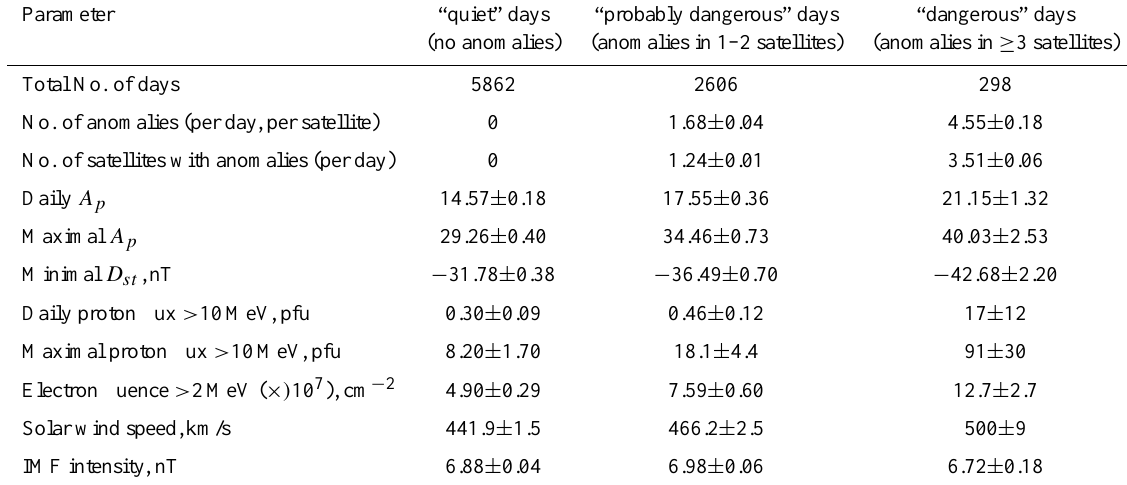
Table 1. Average characteristics of space weather in days with and without satellite anomalies (1971–1994). Parameter “quiet” days “probably dangerous” days “dangerous” days (no anomalies) (anomalies in 1–2 satellites) Total No. of